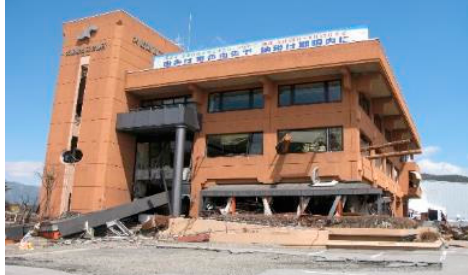
Figure 25. Reinforced concrete building, inundation depth 6.5 m, Ofunato City.